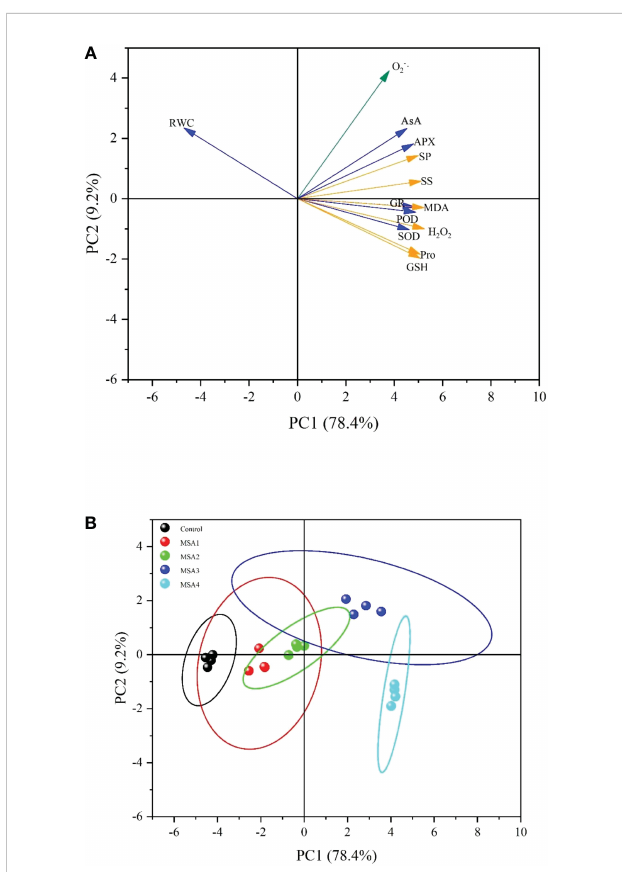
FIGURE 7 Principal component analysis of the measured parameters. (A) , Evaluation Indicator plot. (RWC, leaf relative water content; MDA, malondialdehyde; Pro, proline; SS, soluble sugar; SP, soluble protein, O 2- ·, accumulation of superoxide anion; H 2 O 2 , hydrogen peroxide, SOD, superoxide dismutase; POD, peroxidase; AsA, ascorbic acid; GSH, glutathione; APX, ascorbate peroxidase; GR, glutathione reductase); (B) , Score plot of each group. (MSA1: 40 mM; MSA2: 80 mM; MSA3: 120 mM; MSA4: 160